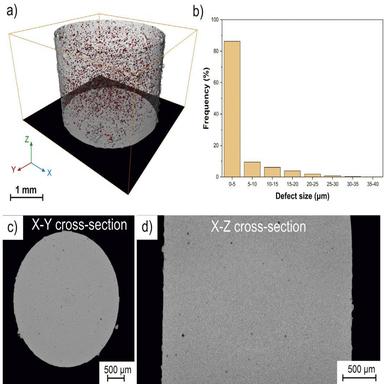
μ-CT analysis of a cylinder with 3 mm diameter and height. (a) 3D distribution of defects inside the cylinder, (b) histogram of the defects' size distribution, (c) snapshot of X-Y crosssection (defects are shown in black), and (d) snapshot of X-Z cross-section.